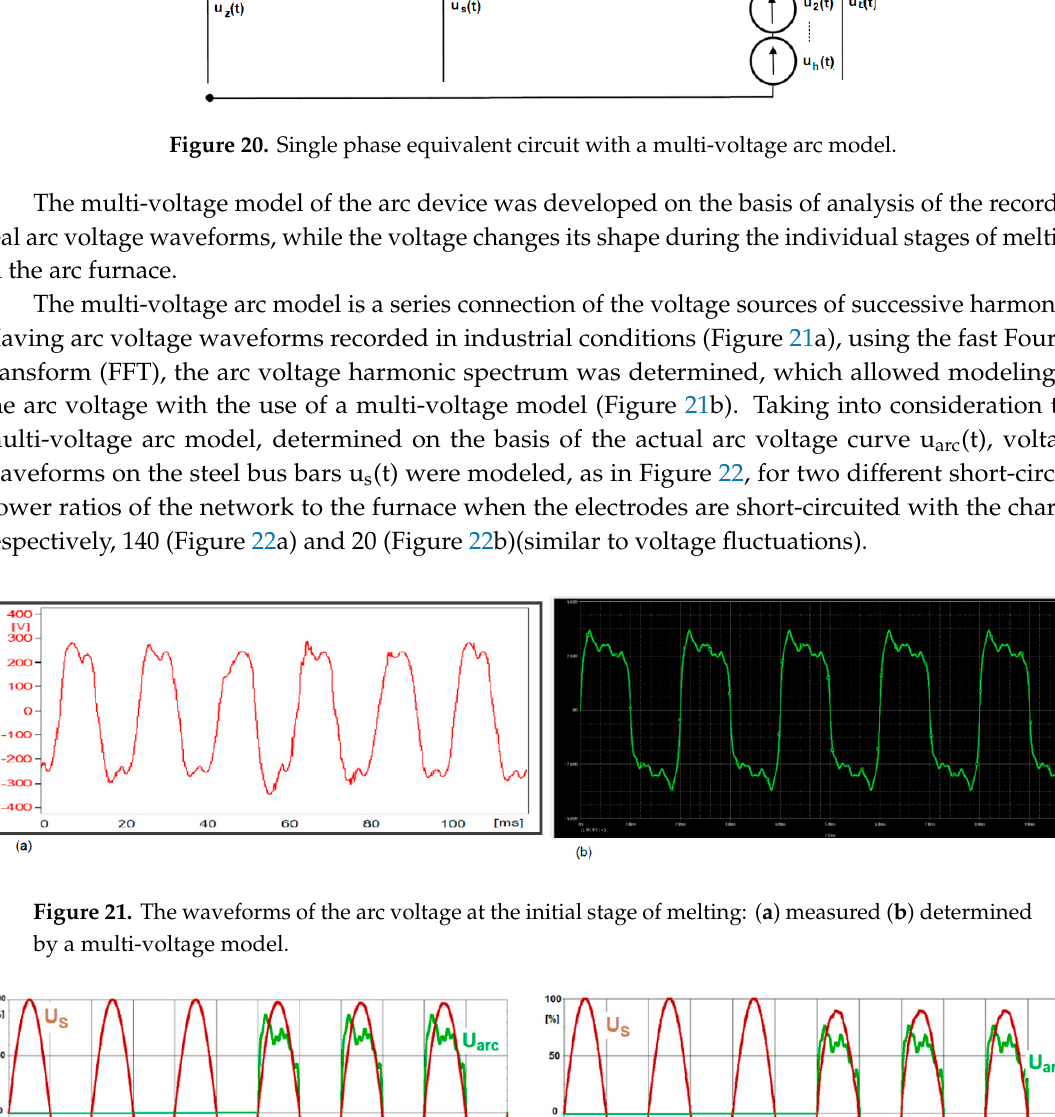
Figure 22. Waveforms of voltage on the rails of the steel plant u s (t) and arc voltage u arc (t) for two different short-circuit powers of the steel supply network, ( a ) S cc / S ctr -140, ( b ) S cc / S ctr =